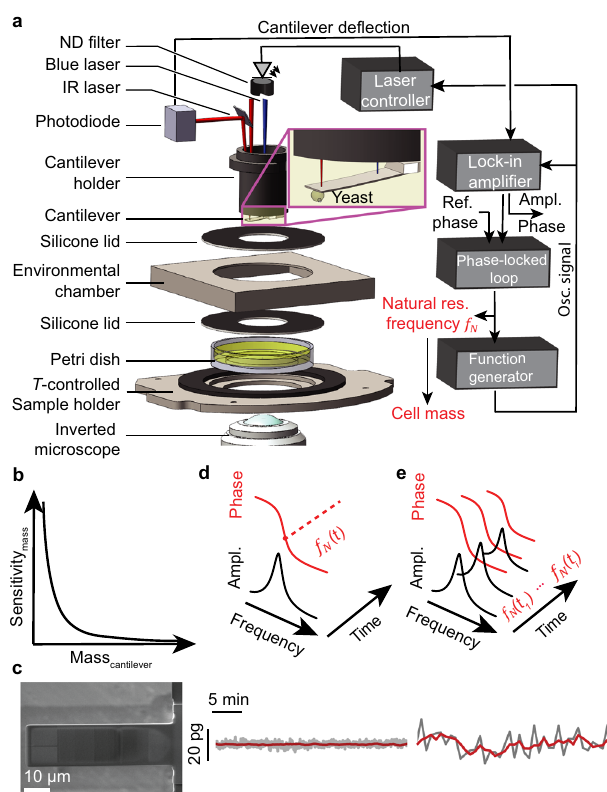
Fig. 1 Experimental set-up for the simultaneous acquisition of mass and morphology of single yeast cells. a Block diagram and main components of the picobalance. The total cell mass is detected by a cantilever that acts as microresonator and cell substrate. A blue laser photoactuates the cantilever at its natural resonance frequency f N and the cantilever movement is detected by an infrared (IR) laser re fl ected onto a photodiode. The blue laser power is reduced by a neutral density (ND) fi lter. Attaching a cell to the cantilever shifts f N , which is tracked over time by keeping the cantilever phase at 90° by a lock- in ampli fi er, phase-locked loop, function generator and laser controller. A temperature (T)-controlled environmental chamber provides cell culture conditions (30°C). The setup is placed on an inverted optical microscope as add-on module. Measurements are acquired in yeast culture medium. b The sensitivity of the cell mass detection is a function of the cantilever mass (see Eqs. (1) and (2), “ Methods ” ). c Scanning electron microscopy image of a silicon nitride cantilever micromachined for yeast cell mass measurements. d Mass measurements ( n = 3 from 3 independent experiments) using the continuous mode (only one measurement shown, all shown in Supplementary Fig. 1c). Top, to attain a high time and mass resolution, f N of the cantilever is continuously tracked by the phase-locked loop (see a ). Bottom, a typical background measurement. On average, the noise is 2.3±0.6pg (mean±SD) while smoothing (100s moving window) reduces the noise to 0.45±0.13pg. e Mass measurements ( n = 3 from three independent experiments) using the sweep mode (only one measurement shown, all shown in Supplementary Fig.1d).Top, to minimize possible impact of the blue laser on cell viability, the cantilever is oscillated across frequency sweeps while recording the cantilever amplitude and phase. In between the frequency sweeps the blue laser is switched off. The sweep mode provides lower mass and time resolution. Bottom, a typical background measurement. On average, the noise is 11.0±1.4pg while smoothing (350s moving window) reduces the noise to